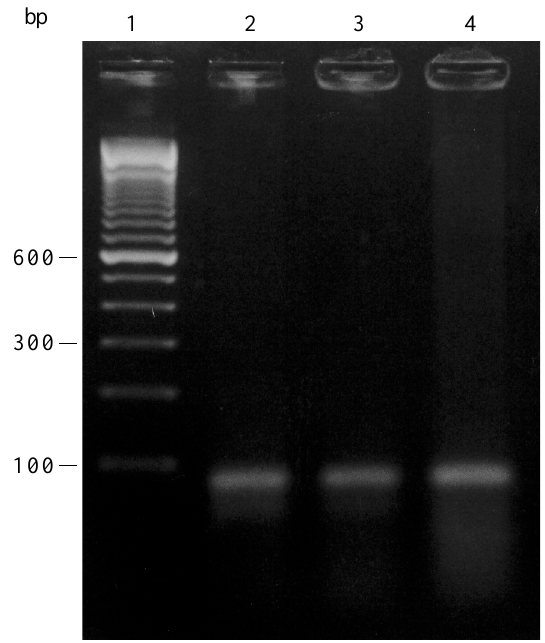
Figure 1 - PCR products obtained using DNA extracted with protocol II. Lane 1 : 100-bp ladder molecular weight marker (Gibco BRL); lane 2 : DNA extracted from a single hair root; lane 3 , DNA extracted from two hair roots, and lane 4 : DNA extracted from three hair roots.